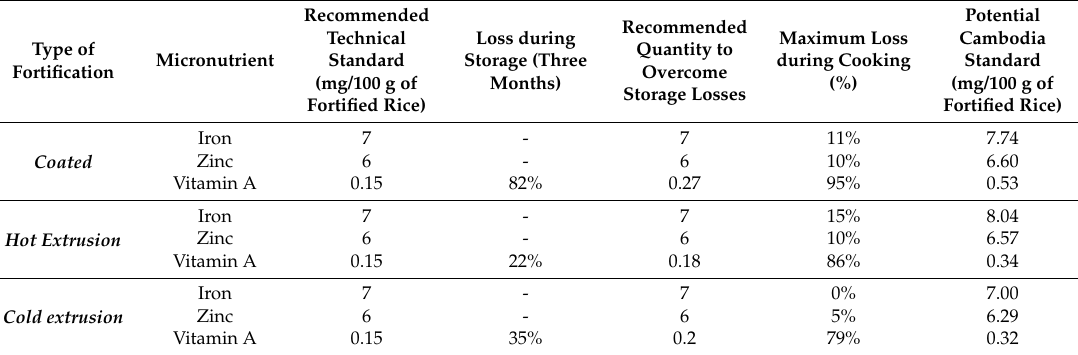
Table 5. Potential standard recommendation for fortified rice in Cambodia for retinyl palmitate, iron and